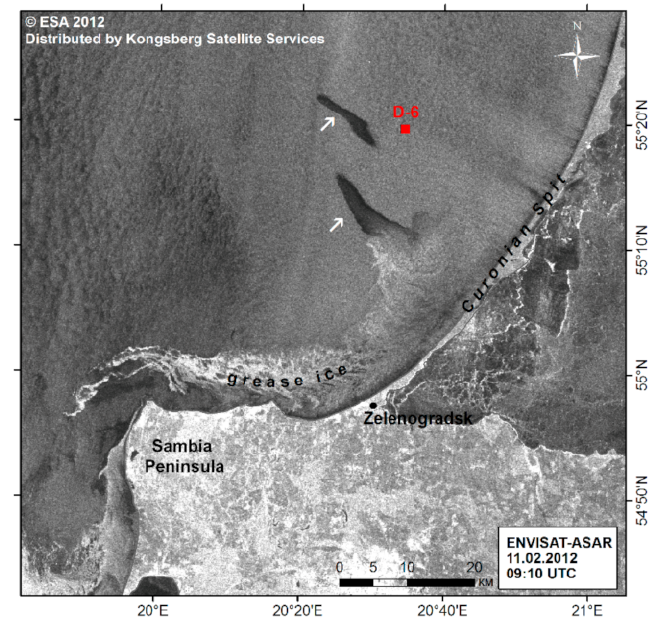
Figure 5. Grease ice propagation along the shore of the Curonian Spit and Sambia Peninsula (ASAR- ENVISAT, 11 February 2012). Arrows show grease ice propagation. A red dot shows the location of the D-6 platform.